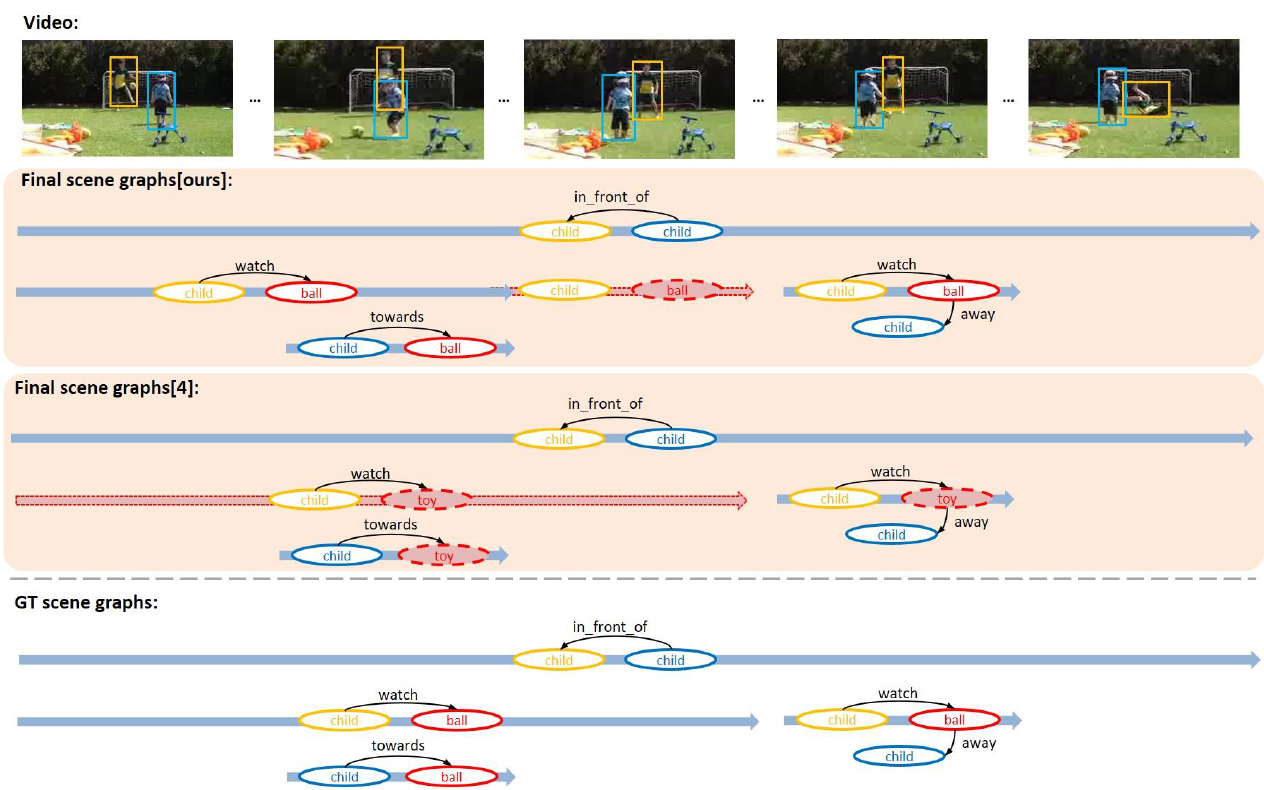
Figure 8. Third example of VidSGG task performed by the proposed model.